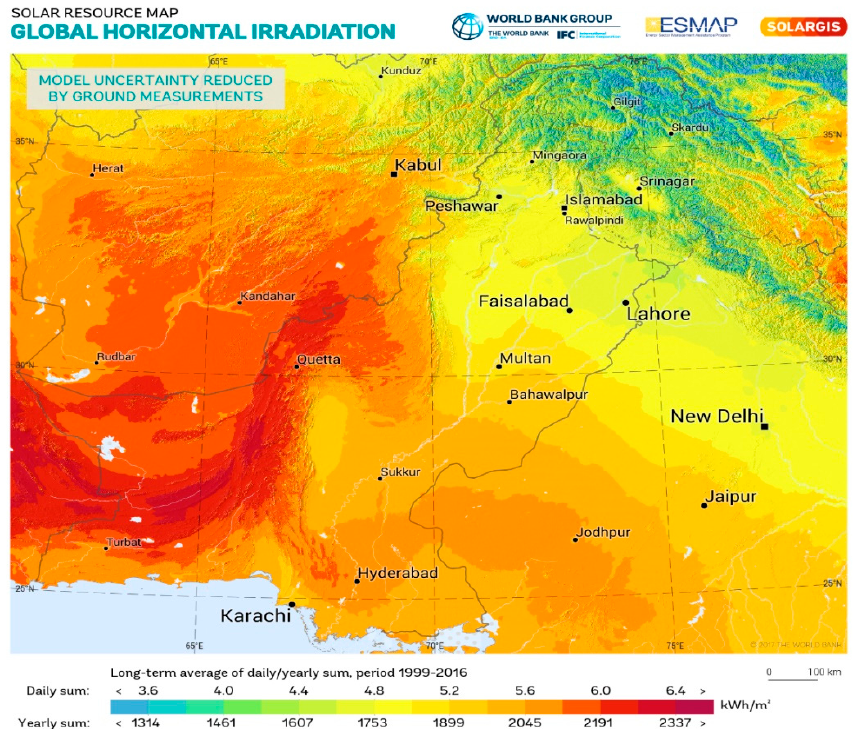
Figure 7. Pakistan map.